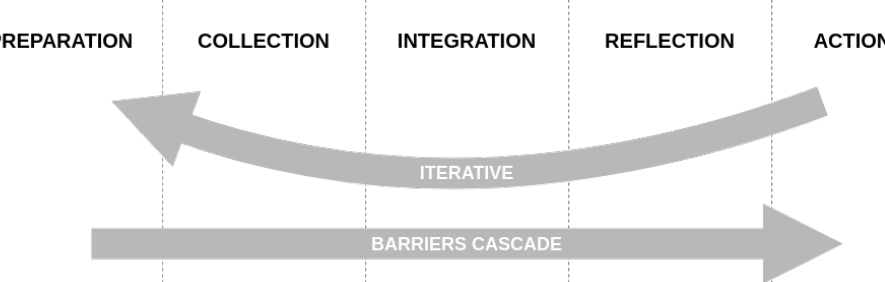
Figure 1. Adapted from Li et al.’s Stage-Based Model of Personal Informatics Systems: this shows the progression of a person toward behavior change through the different stages of a self-quantification experience with its iterative nature and its